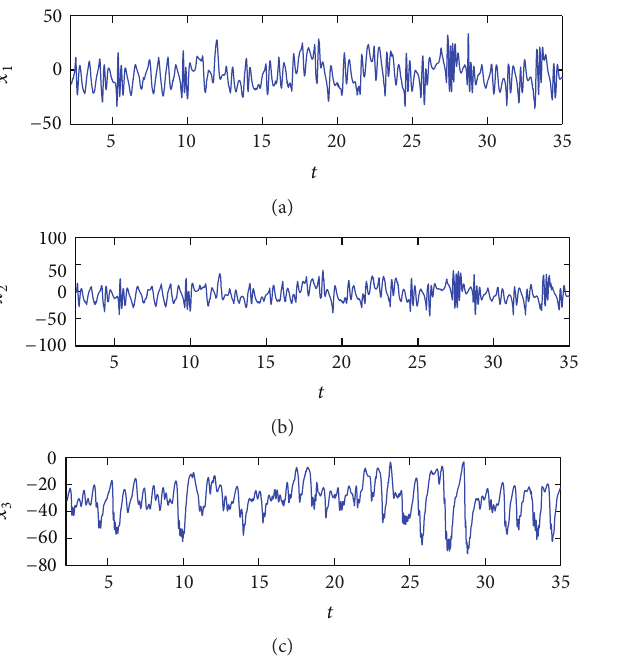
Figure 2: Time responses of error system under control input in Example